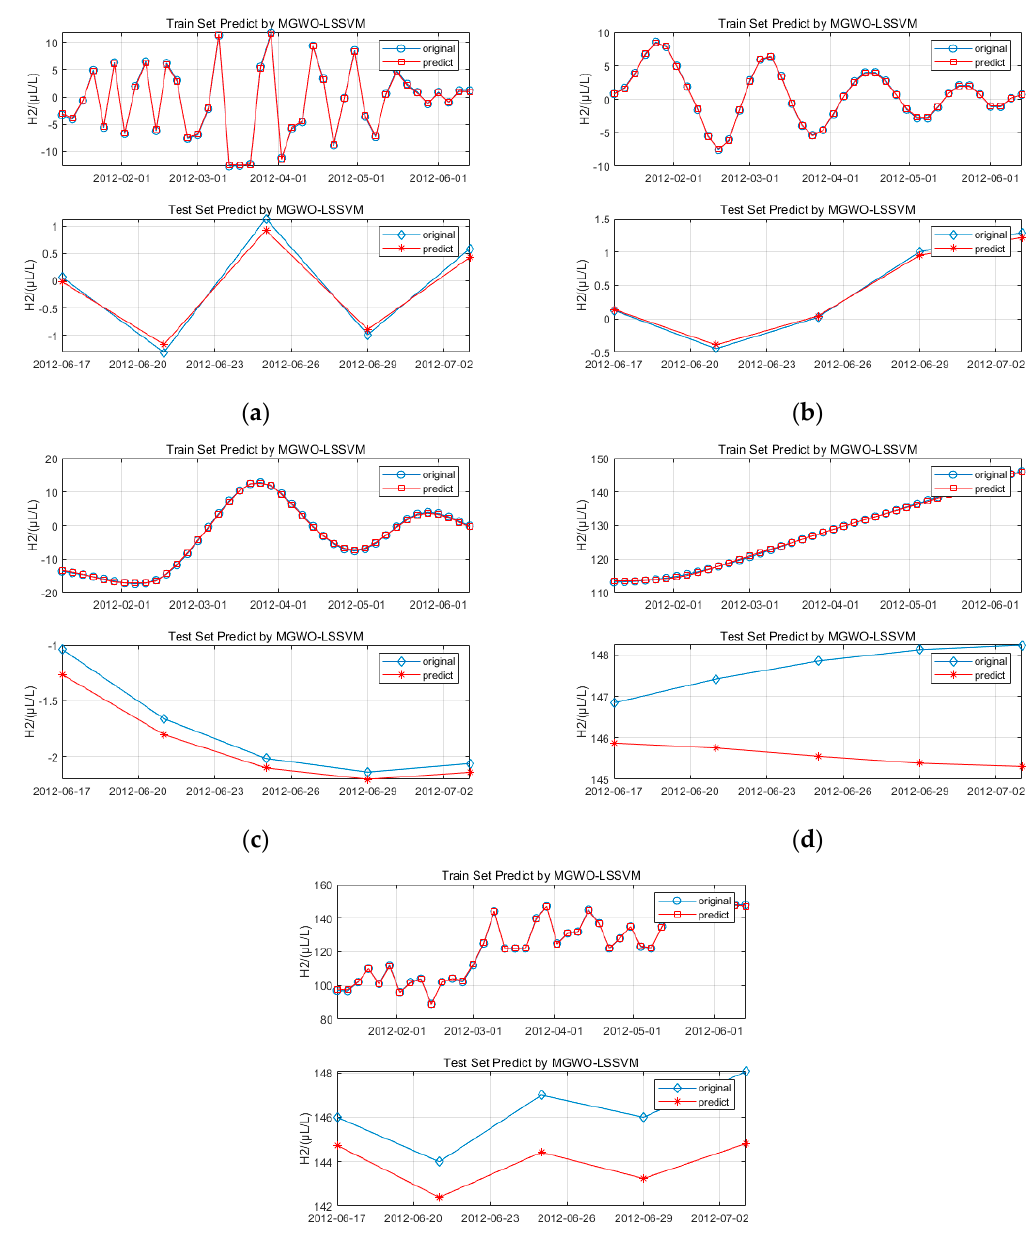
Figure 3. Prediction results of H 2 by the GRA-EMD-MGWO-LSSVM model. ( a ) intrinsic mode function 1 (IMF1); ( b ) IMF2; ( c ) IMF3; ( d ) residual and ( e ) H 2 .